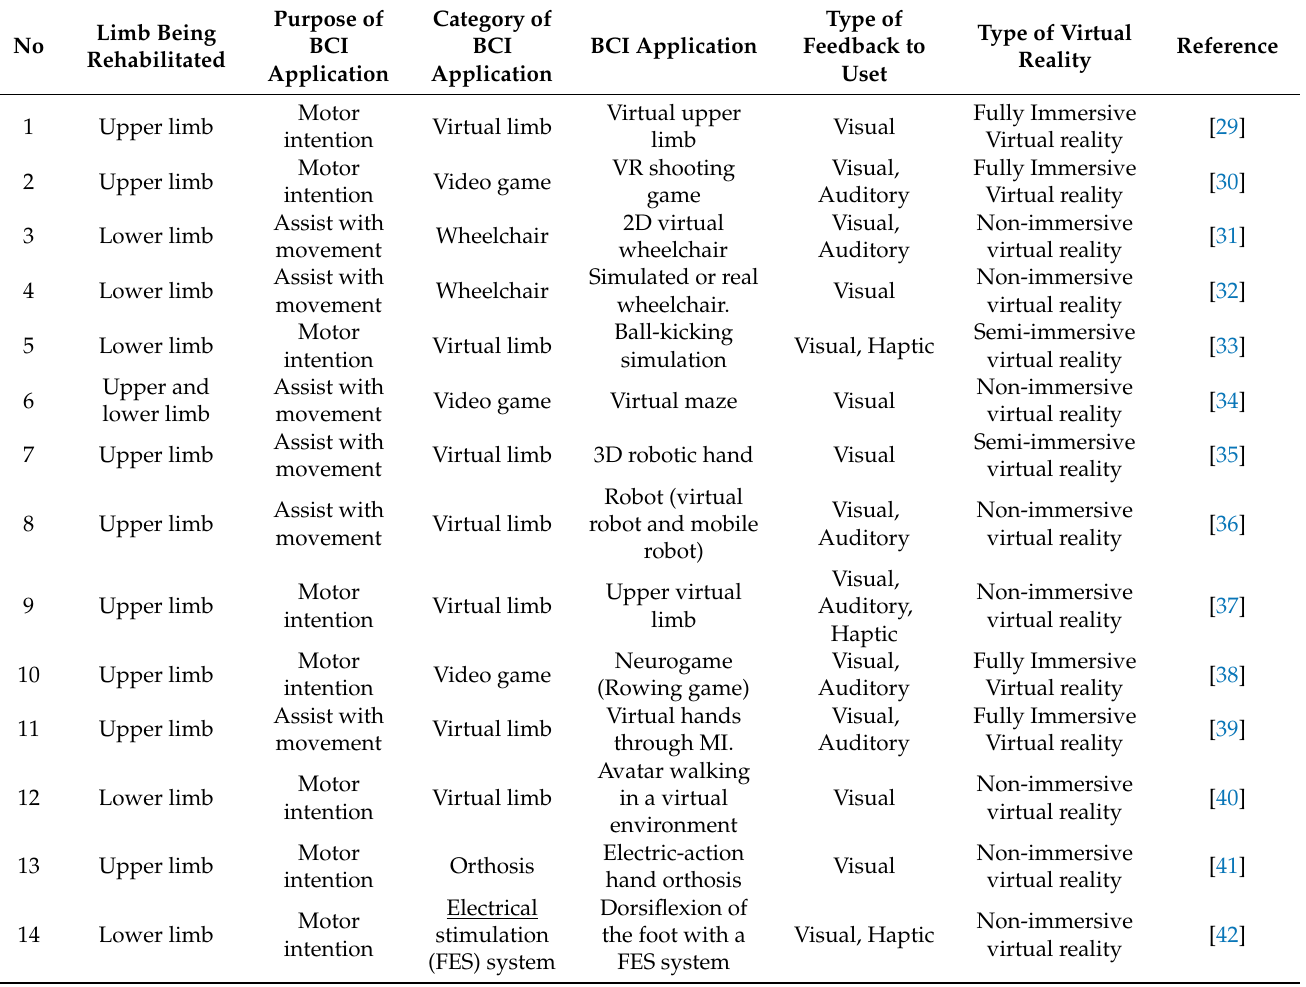
Table 2. Main characteristics of the included